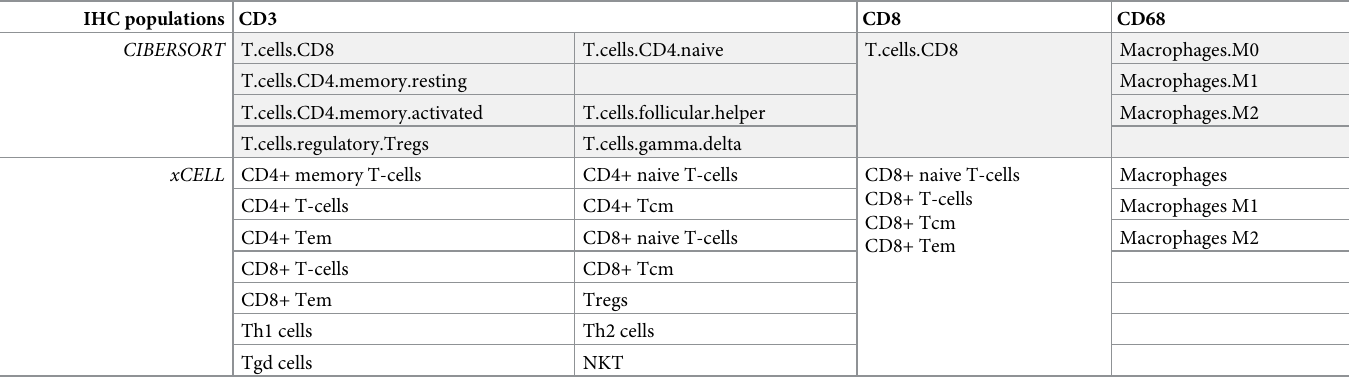
Table 2. Assembly of composite RNASeq-calculated populations to match cell types detected by IHC. IHC populations